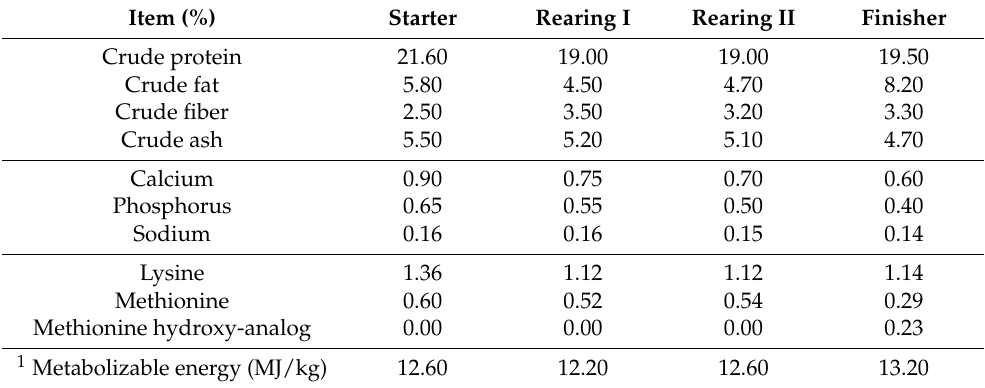
Table 1. Chemical composition of the commercial diets in accordance with the ingredient declaration. Item (%)